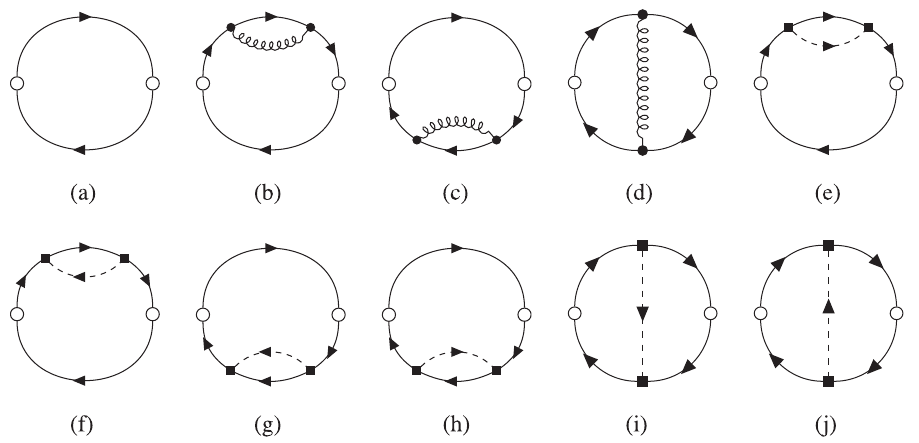
FIG. 6. Diagrams contributing to the numerator N 1 [Eq. (B4)] of h O 1 i ¼ h S a ð τ Þ S a ð 0 Þi . Conventions are as in Fig. 5, and an open circle denotes the external S a